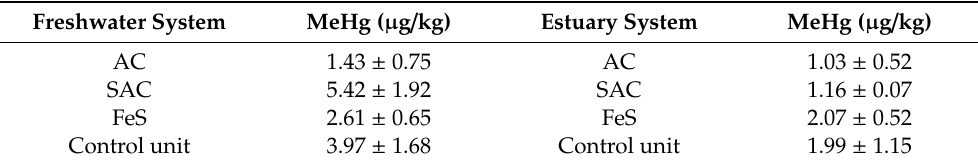
Table 4. The MeHg content in sediment on day